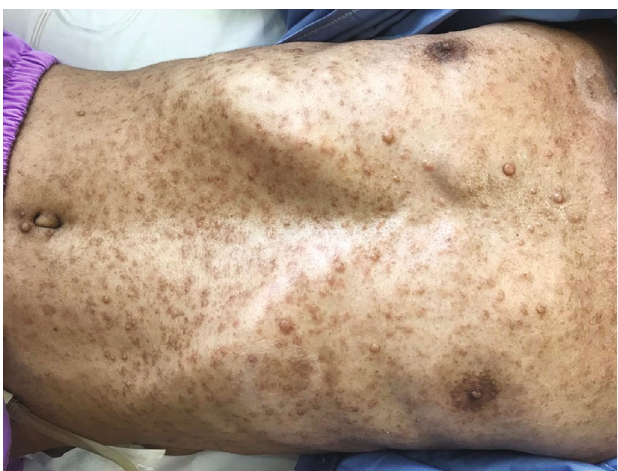
Figure 1: Di ff use cutaneous nodules and café-au-lait spots.